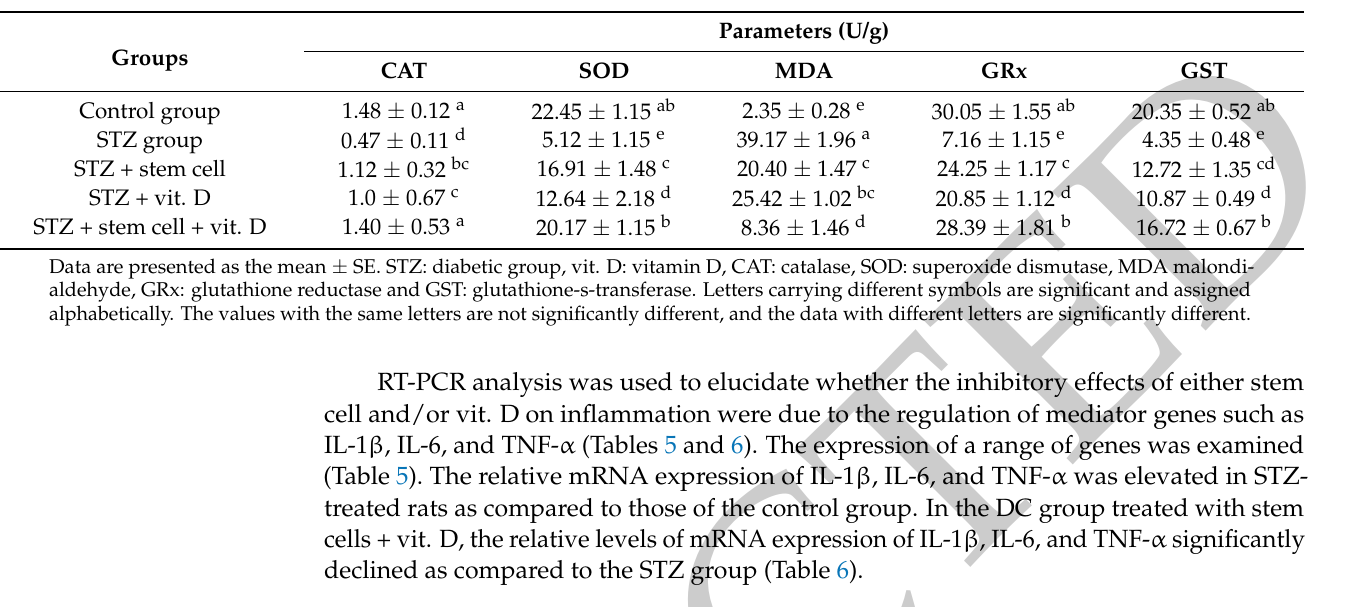
Table 4. Changes in oxidative/antioxidant enzymes in pancreatic tissues of control and male rats treated with stem cells, vitamin D, and their combinations.